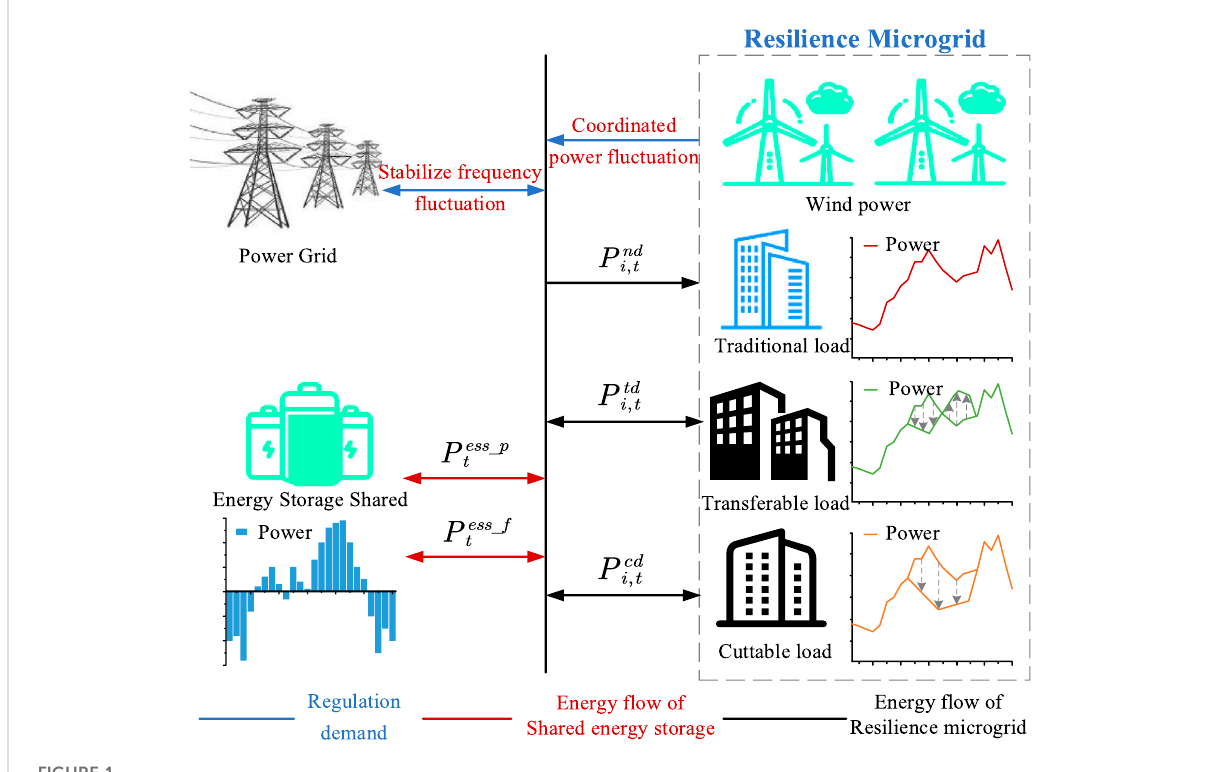
FIGURE 1 Operation mode diagram of centralized shared energy storage in the